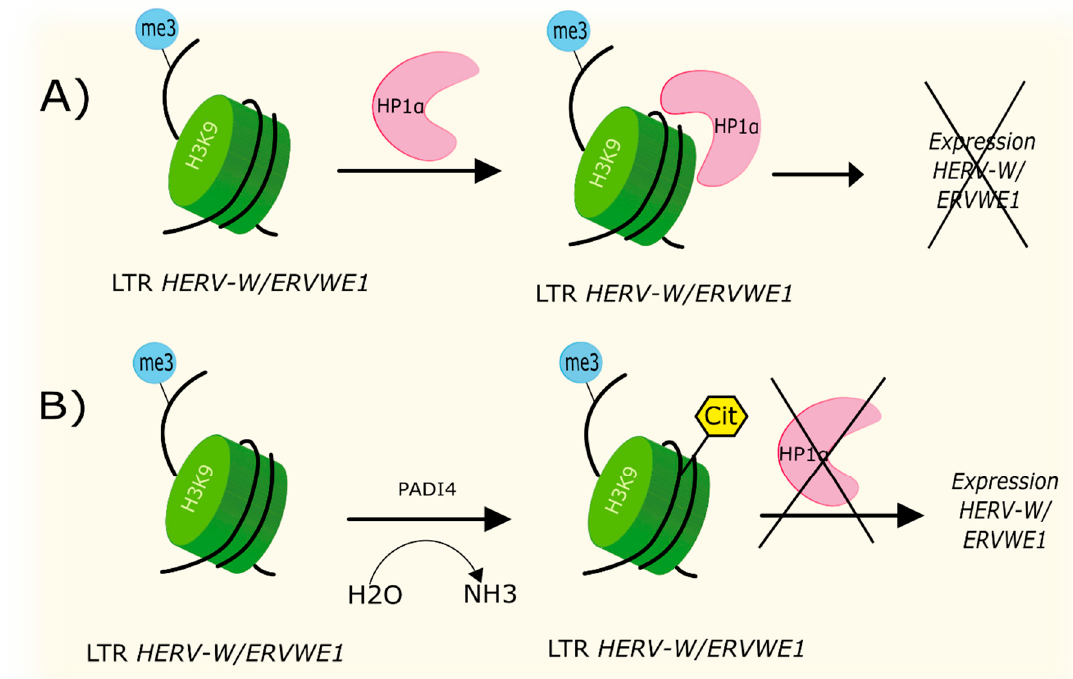
Figure 3. The mechanism of regulation of HERV ‐ W transcription by histone citrullination. ( A ) Repression of HERV ‐ W transcription upon the interaction of HP1 α with histone H3K9 in LTR. ( B ) Enhanced expression of HERV ‐ W due to the formation of citrullinated H3K9 histone by